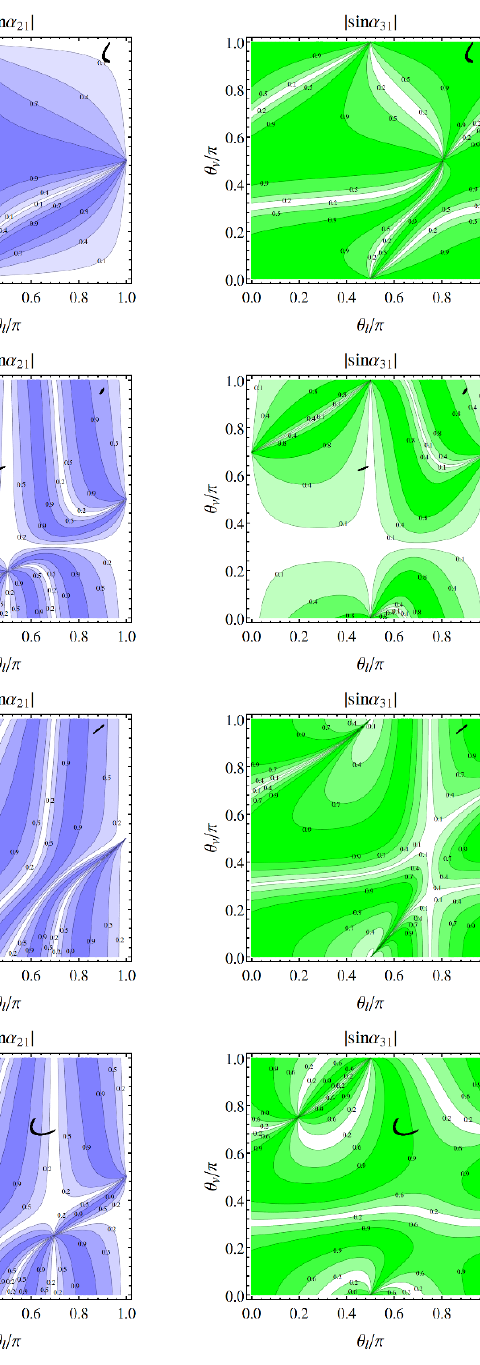
Figure 7 . The contour plots of the CP violation phases j sin (cid:14) CP j , j sin (cid:11) 21 j and j sin (cid:11) 31 j for the mixing pattern U II ; 2 , where the parameters ( ’ 1 ; ’ 2 ) are equal to (0 ; (cid:25)= 4), ( (cid:25)= 4 ; 0), ( (cid:25)= 4 ; (cid:25)= 4) and ( (cid:25)= 2 ; (cid:25)= 4) in the four rows panels, respectively. The black areas represent the regions for which all the three lepton mixing angles lie in their corresponding experimentally allowed 3 (cid:27) intervals [8]. Since U II ; 2 and U II ; 4 are related through the exchange of the second and the third rows of the mixing matrix, they lead to the same Majorana phases (cid:11) 21 and (cid:11) 31 while the Dirac phase changes from (cid:14) CP to (cid:25) + (cid:14) CP .